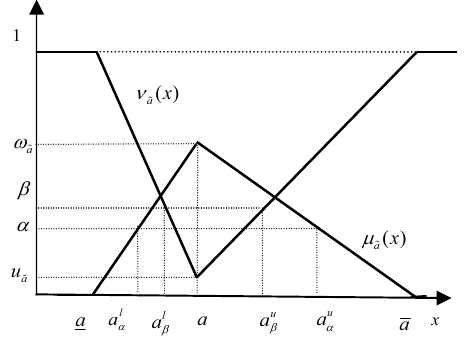
Fig. 1 (cid:68) -cut set of membership function and (cid:69) -cut set of